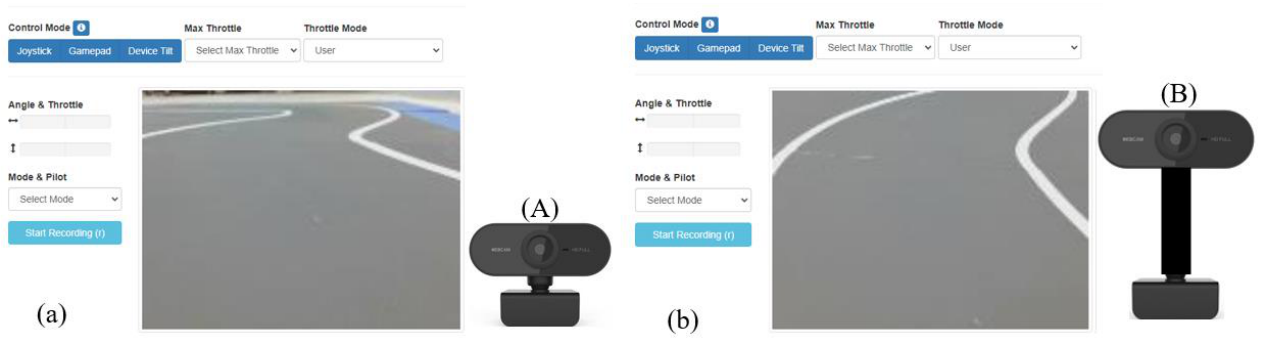
Figure 16. Experimental field: ( a ) the view from position (I), ( b ) the view from position (II). The experimental conditions are as described in Section 3.2, “Experimental